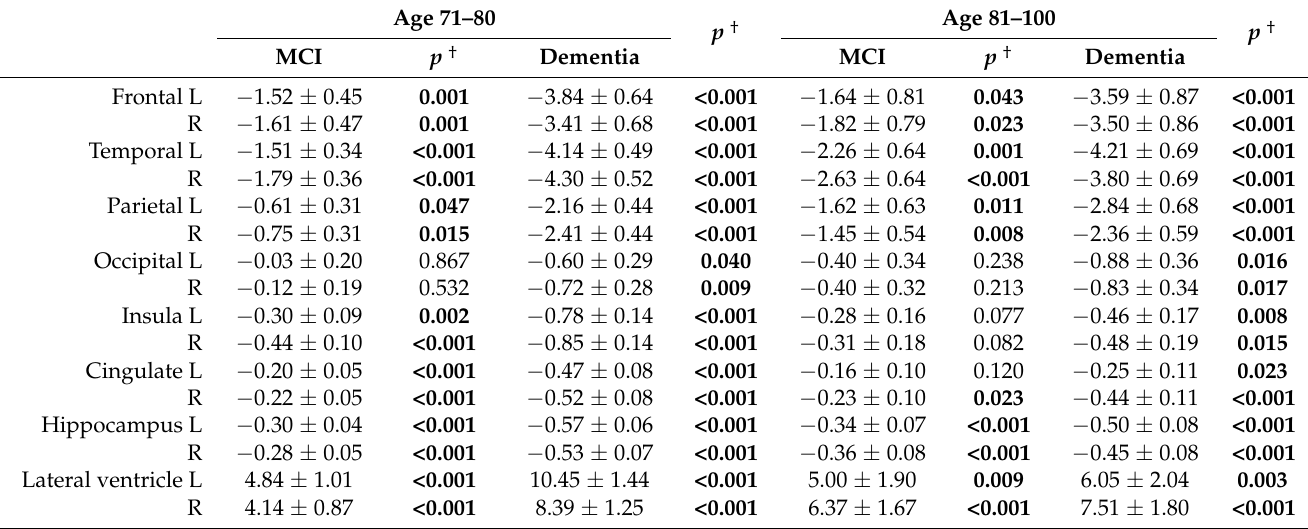
Table 3. Age categorized